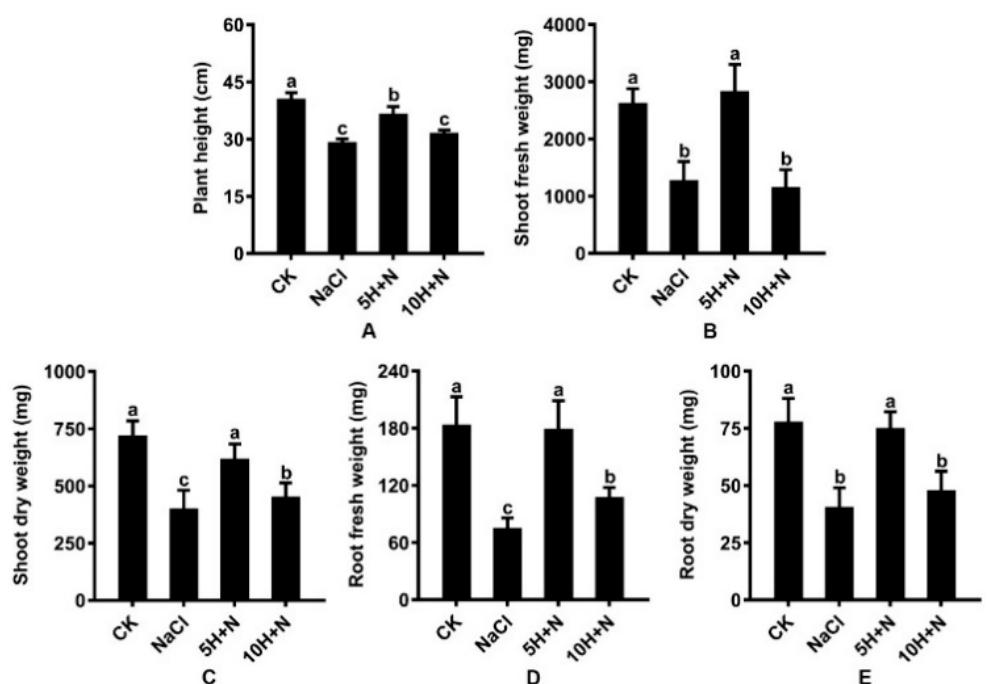
Figure 2. Effects of exogenous H 2 O 2 on PH ( A ), SFW ( B ), SDW ( C ), RFW ( D ), and RDW ( E ) of Tartary buckwheat under NaCl stress. CK: control, H 2 O foliar spray + H 2 O irrigation, NaCl: H 2 O foliar spray + 150 mmol·L − 1 NaCl irrigation, 5H + N: 5 mmol·L − 1 H 2 O 2 foliar spray + 150 mmol·L − 1 NaCl irrigation, 10H + N: 10 mmol·L − 1 H 2 O 2 foliar spray + 150 mmol·L − 1 NaCl irrigation. PH: plant height (cm), SFW: